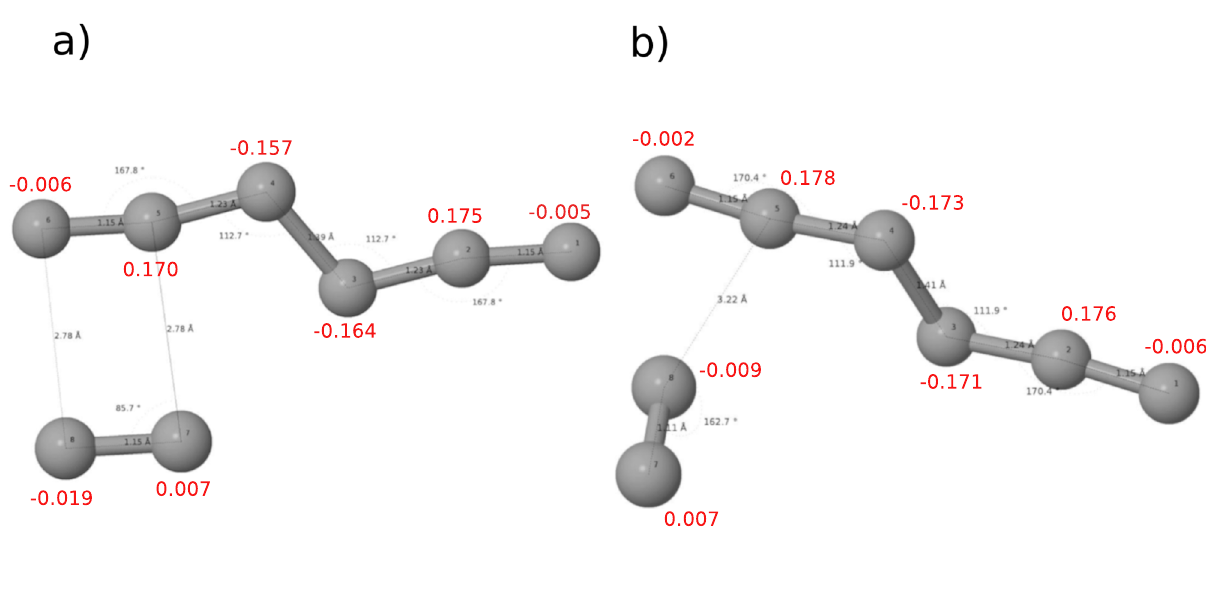
Figure 6. Intra- and inter-molecular bond lengths and angles along with the natural charge distribution from natural bonding orbital (NBO) analysis in the N 6 –N 2 system: ( a ) for the C 2 h (2/m) phase found at 5 GPa and ( b ) for the C i ( 1 ) found at 0